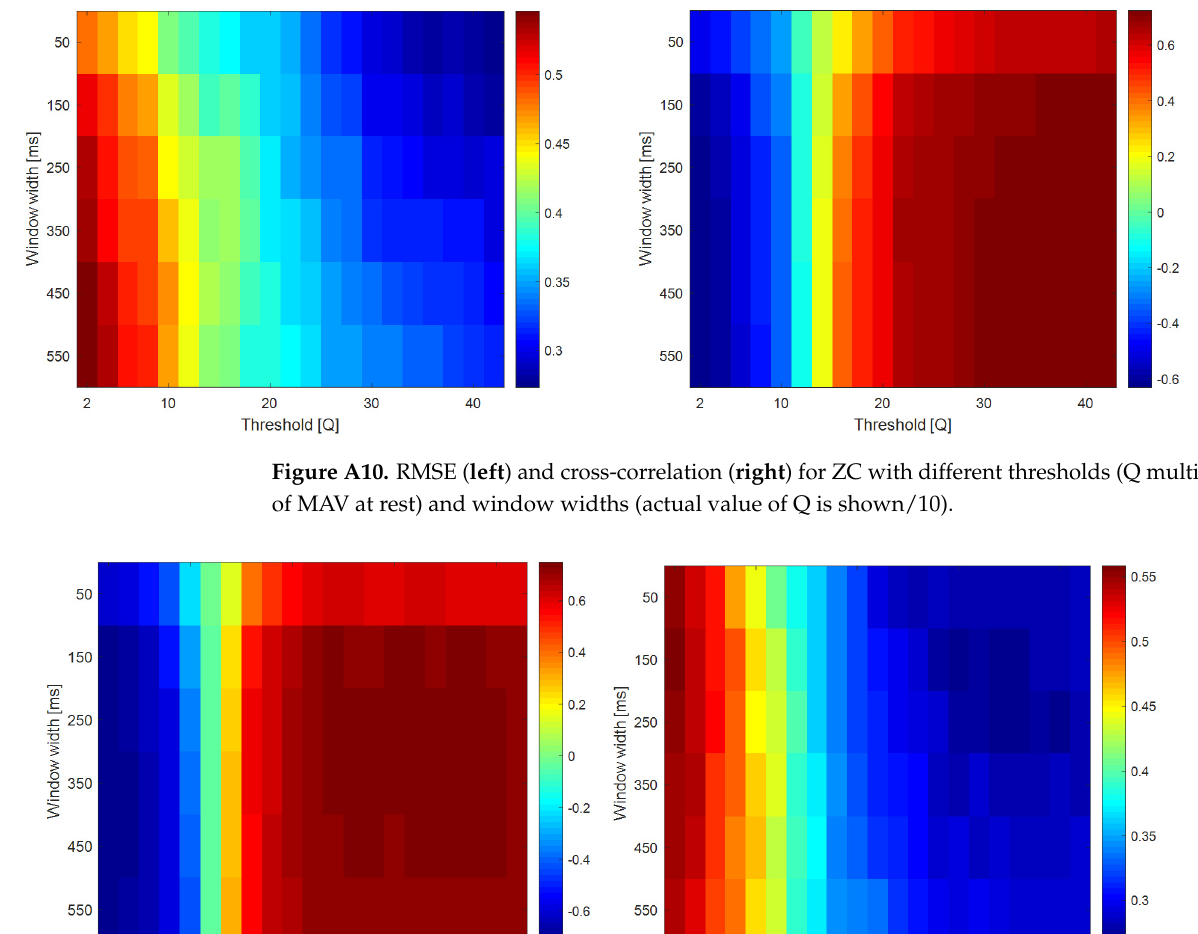
25 of 28 Figure A9. RMSE ( left ) and cross-correlation ( right ) of MDF algorithm for different window sizes. Table A9. Statistical significance between window sizes for MDF algorithm. Green indicates statis- tically significant difference ( p < 0.05; Bonferroni-corrected) for the RMSE metric, and orange indi- cates significant difference ( p < 0.05; Bonferroni-corrected) for the cross-correlation metric. Grey in- dicates diagonal fields. ms